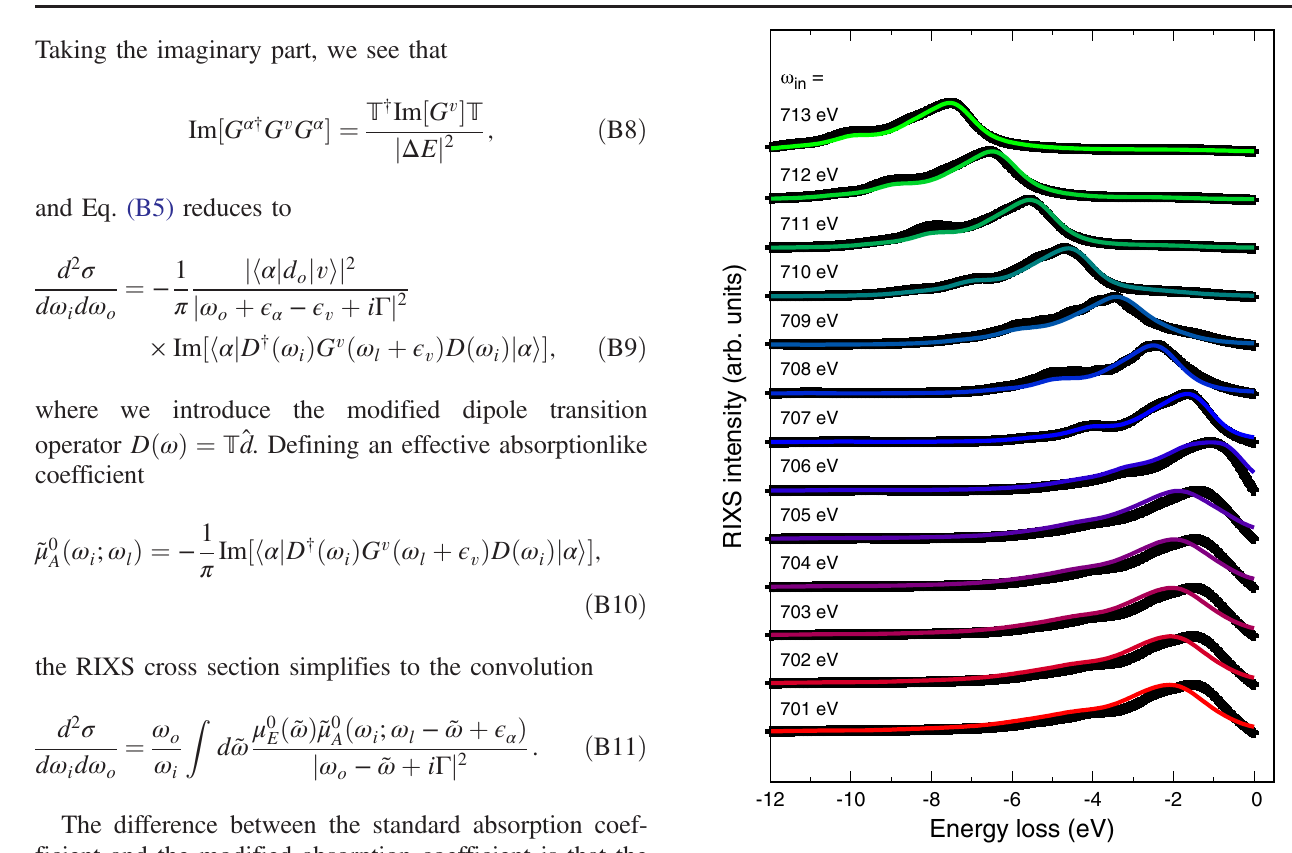
FIG. 13. Comparison of RIXS spectra calculated with the full Kramers-Heisenberg equation by Eq. (8) (black curves) and with the quasiboson model for the direct RIXS response in Eq. (13) using the bare BSE absorption and emission spectra μ 0 respectively (colored curves). Incident photon energies are indicated. All spectra are peak-height normalized to improve visual comparison. For all sets of curves, the intermediate (final) state HWHM broadening is 0.20 eV (0.36